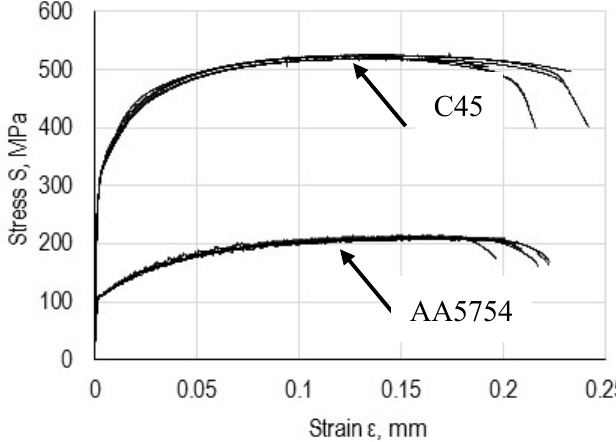
Figure 16. Stress diagrams as a function of strain of steel C45 and aluminium alloy 5754.